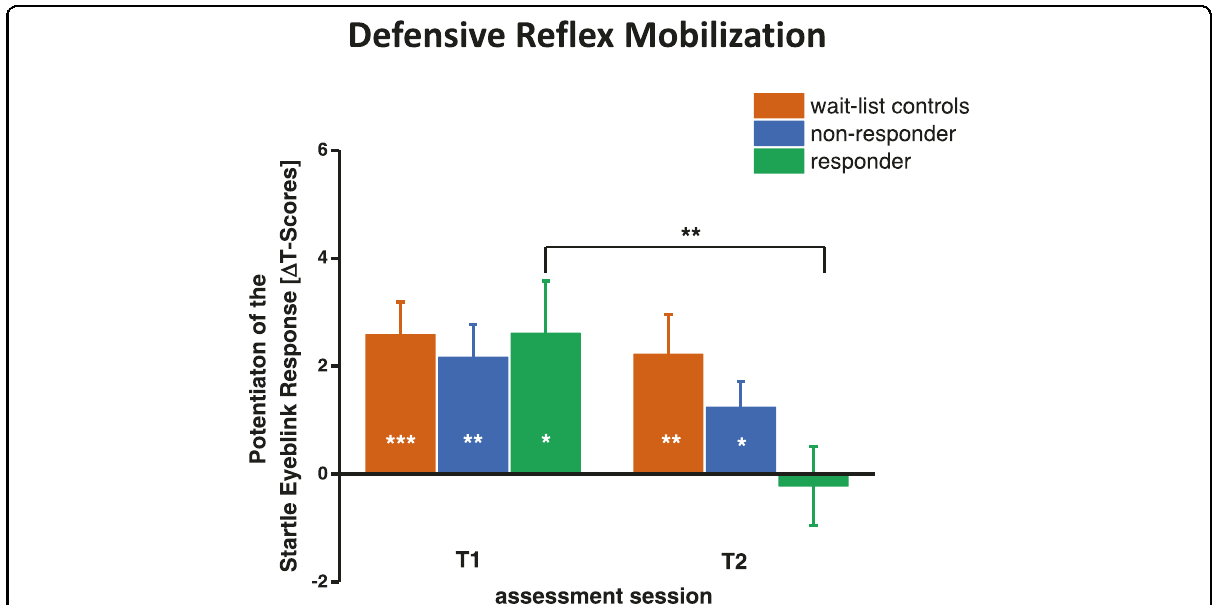
Fig. 3 Defensive re fl ex mobilization during the post-hyperventilation phase vs. control condition. Means and standard errors of the potentiation of the startle eyeblink re fl ex during the post-hyperventilation phase vs. control condition in wait-list-controls, treatment non-responder and responder at T1 and T2. Asterisks denote a signi fi cant potentiation of the startle eyeblink response during the post-HV phase compared to the safe condition. In responders, asterisks indicate a signi fi cant reduction of this potentiation from T1 to T2. *** p < 0.001, ** p < 0.01, * p <